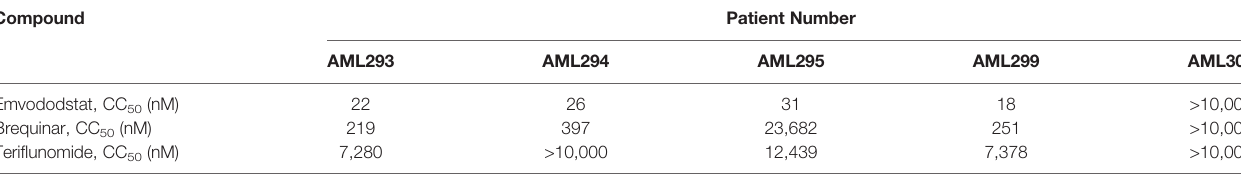
TABLE 3 | Summary of sensitivity of primary AML cell culture with emvododstat, brequinar, and teri fl unomide.